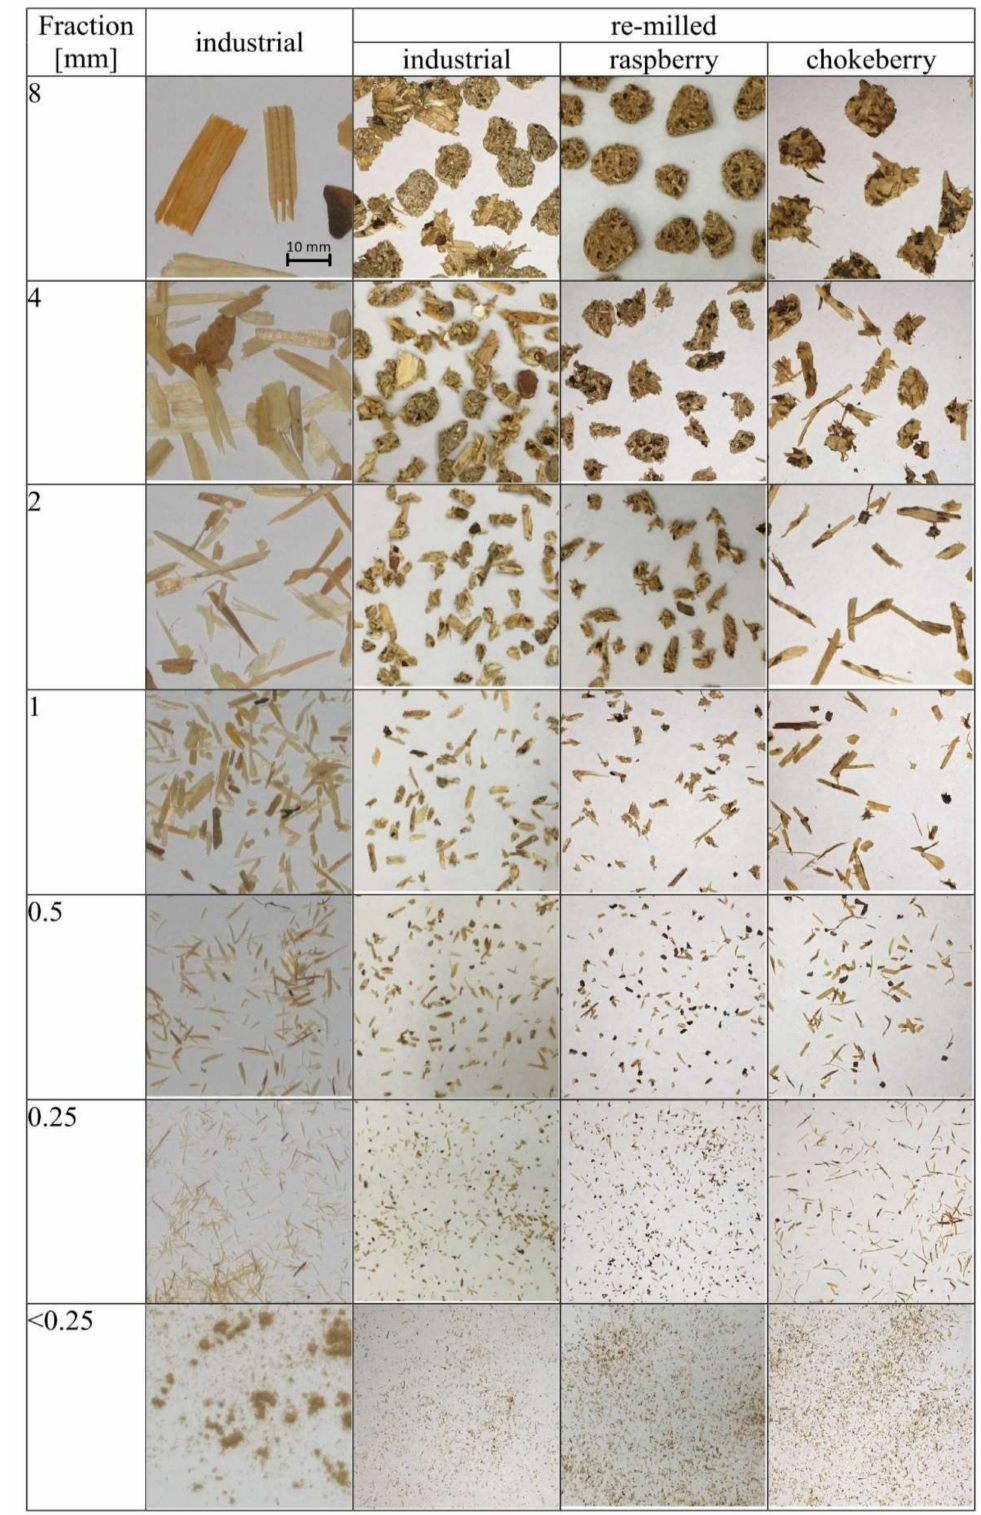
Figure 11. Pictures of the morphology of particles produced by re-milling the tested composites compared to industrial particles (each picture dimension is 50 mm